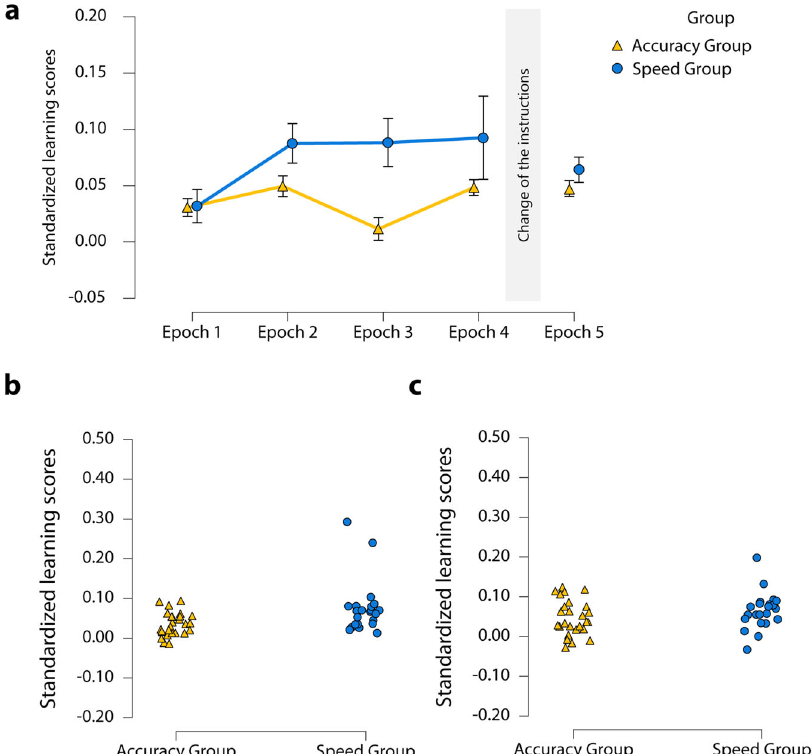
Fig. 1 Learning of probability-based regularities. a The dynamics of learning of probability-based regularities with accuracy or speed instructions. The y -axis represents the standardized learning scores [(random low-probability trials − random high-probability trials in the given epoch)/median RTof the given epoch], and the x -axis of the fi ve epochs (the fi rst four are of the Different Instruction Phase, and the fi fth one is of the Same Instruction Phase). The Accuracy Group is presented with yellow, while the Speed Group with blue color. Error bars represent the standard error of the mean. In the Different Instruction Phase, the Speed Group shows an advantage of learning, but it disappears in the Same Instruction Phase. b Individual data of the signi fi cant main effect of Group of probability-based learning in the Different Instruction Phase. Triangles and dots represent the individual data points. c Individual data of the lack of signi fi cant main effect of Group of probability-based learning in the Same Instruction Phase. Triangles and dots represent the individual data